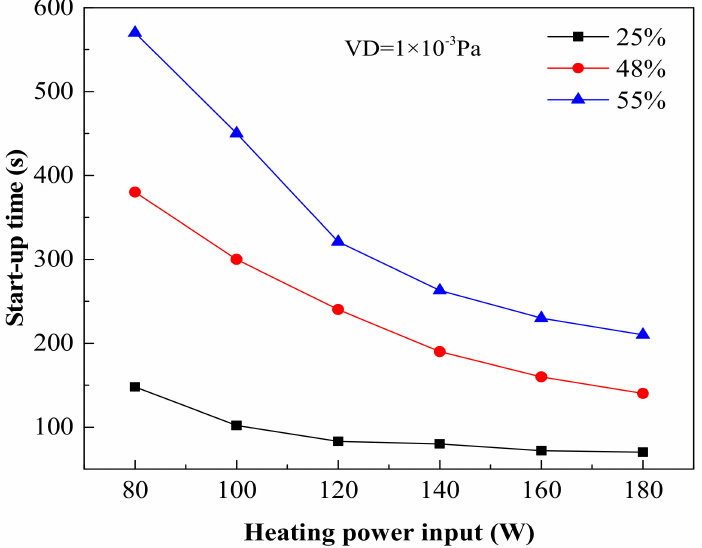
Figure 9. The variation of the start-up time of the PGHP with the heating power input at different fluid filling